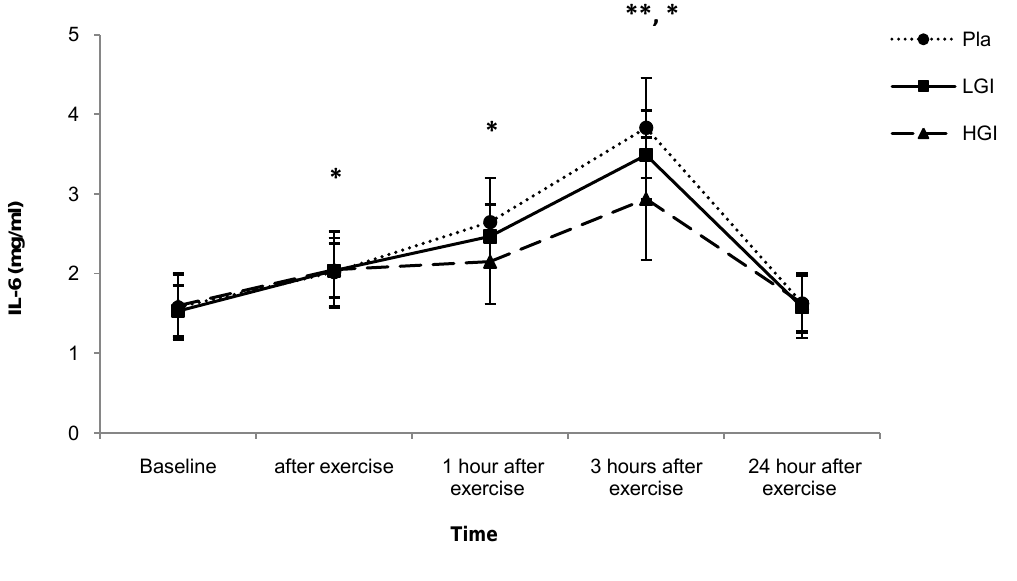
Fig. 1. Mean concentration of plasma IL-6 for Pla, LGI and HGI diet groups at the various time points